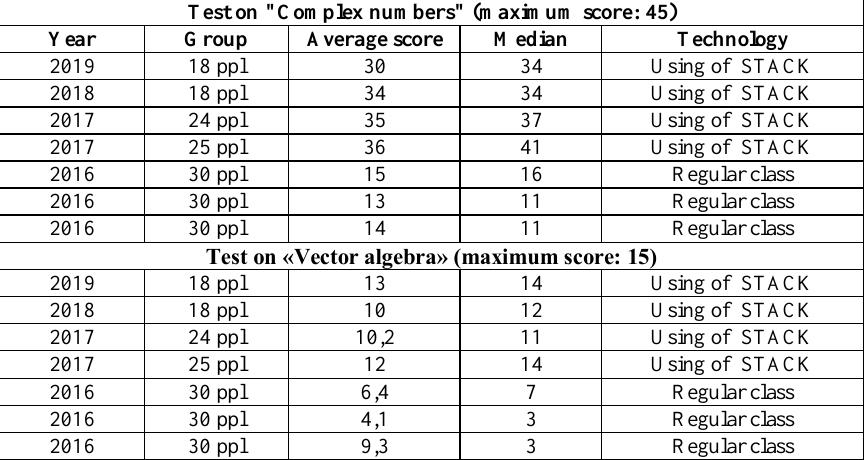
Table 1. Results of tests for students, studied with and without using method described in p.3.1. Test on "Complex numbers" (maximum score: 45)